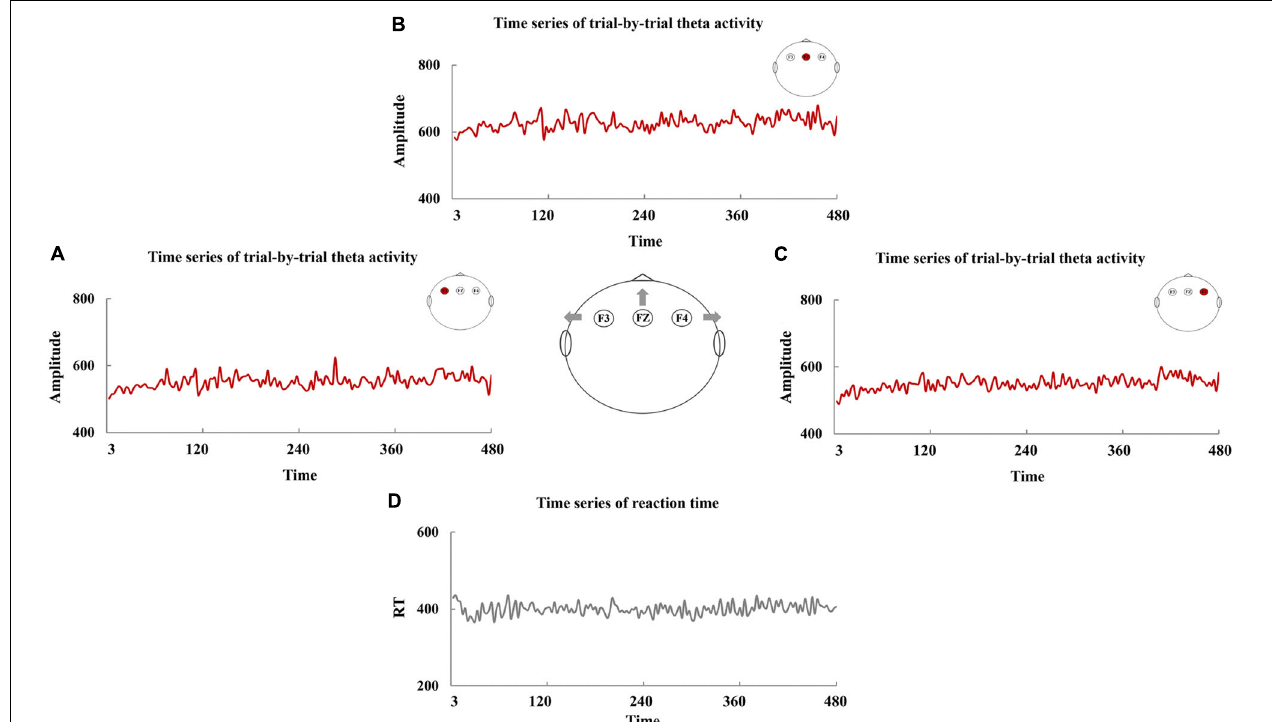
FIGURE 3 | The time series of trial-by-trial theta activity and reaction time (RT). The time series of trial-by-trial theta activity at F3 (A) , FZ (B) , and F4 (C) and the time series of RT (D) .